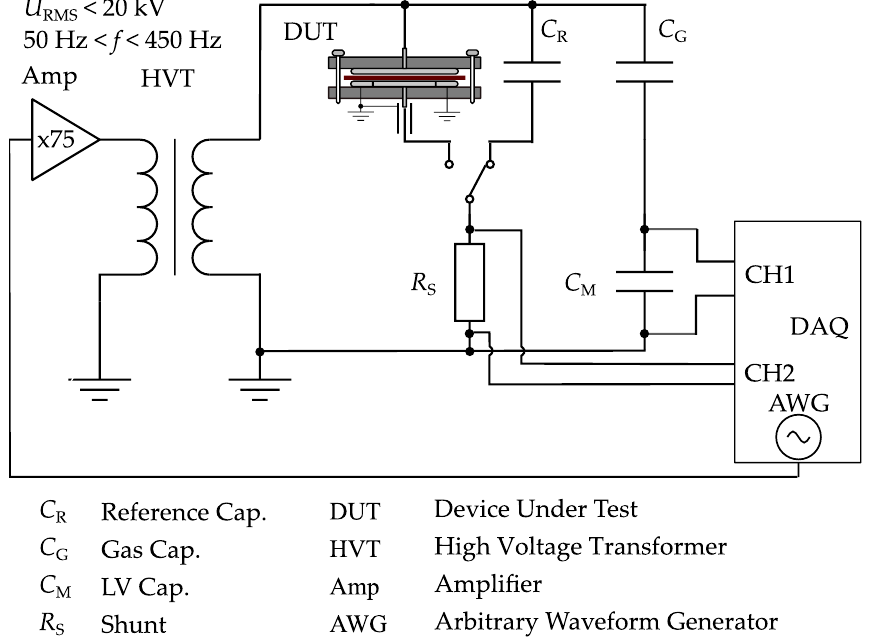
Figure 3. Test setup for measurements at AC and distorted